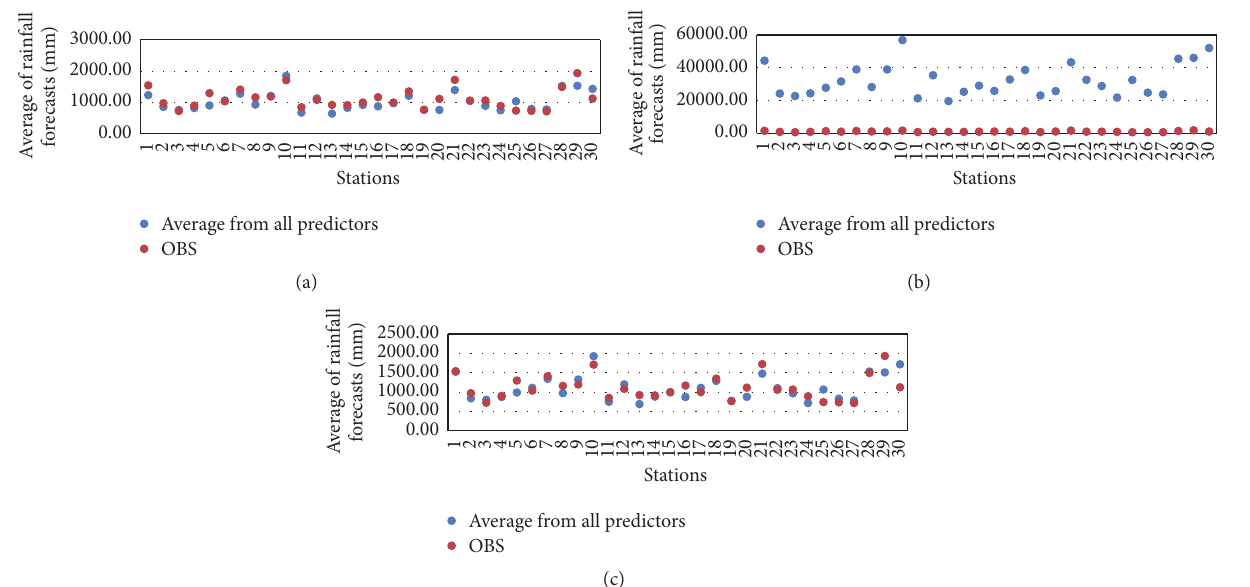
Figure 13: Comparison between averages from all predictors of rainfall forecast (mm) (horizontal axis) and stations (vertical) of (a) AM, (b) CAM, and (c) MCAM. For averages rainfall forecast during 15 May to 15 October 2010 at 30 stations in Thailand.